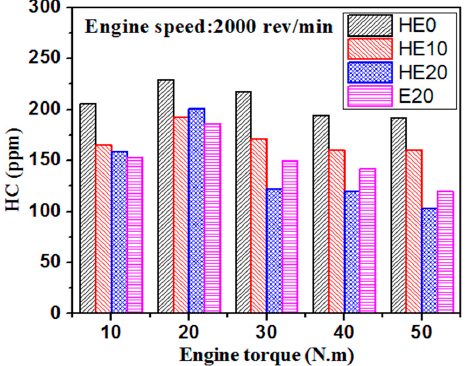
Figure 11. Variation of HC emission with engine load.